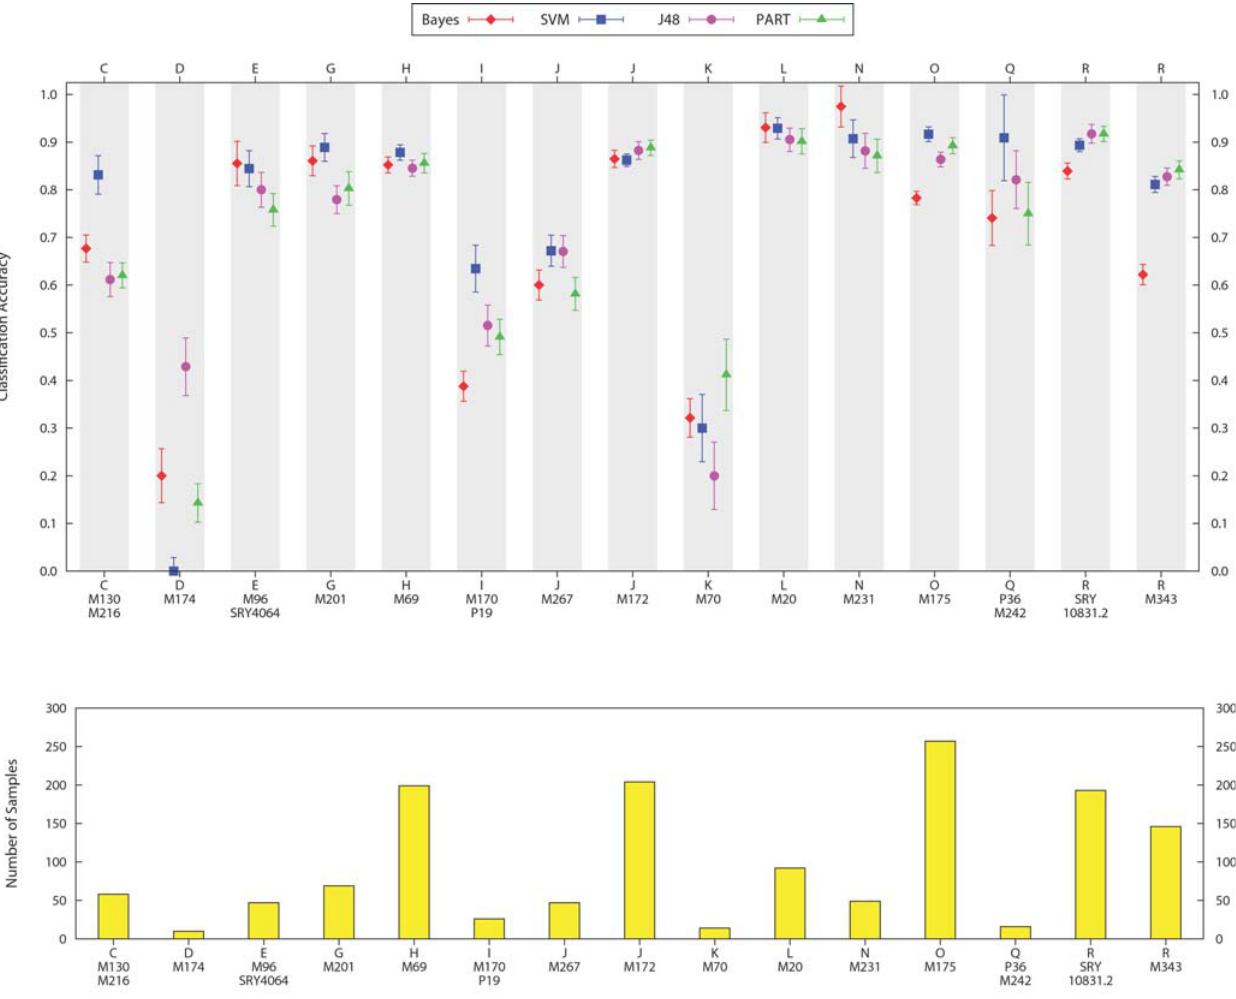
Figure 5. Average accuracy of each classifier per haplogroup for cross-validation on the 9-locus public STR data. Standard error bars are shown for each point. The lower panel shows the frequency of haplogroups in the 1,527 sample public data set.